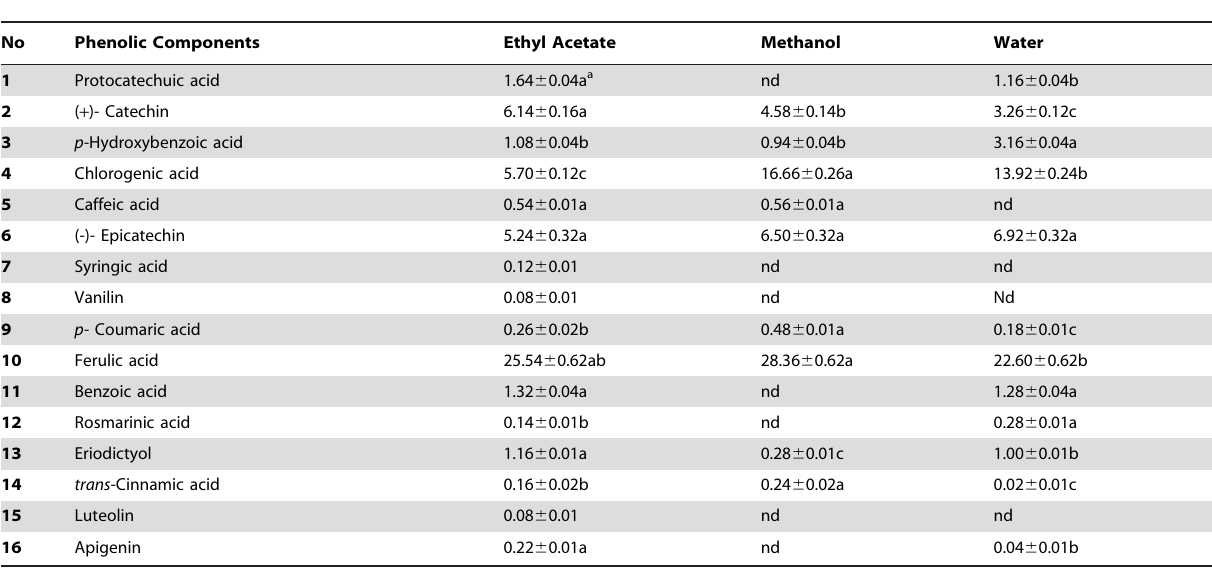
Table 2. Phenolic components in the solvent extracts from Cotoneaster nummularia (mg/g extract) (mean 6